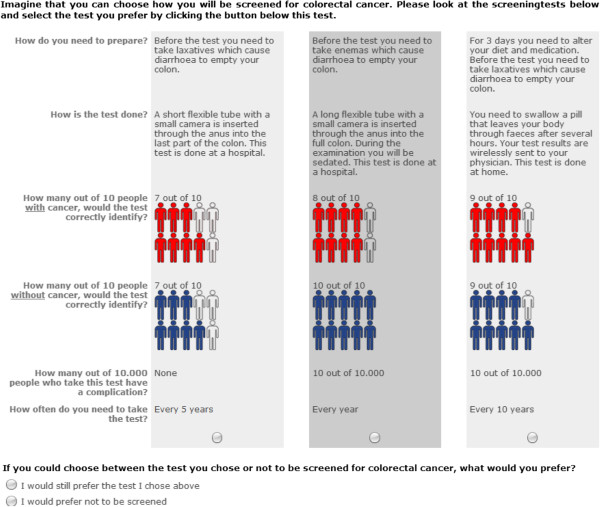
Choice set example.